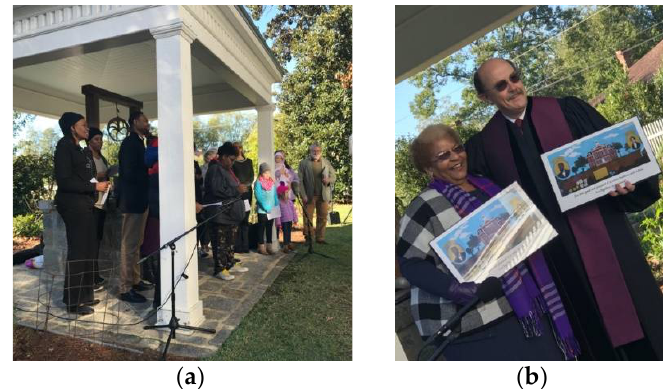
Figure 6. ( a ): Choir members of Holsey Memorial CME Church and Pierce Memorial United Meth- odist Church singing together at the Sunshine wedding re-enactment. ( b ): Reverend Gwendolyn Smith is pastor at Holsey Memorial CME Church in Sparta. Darrell McGinnis is pastor at Pierce Memorial United Methodist Church in Sparta. They are pictured together holding placards cele- brating the wedding re-enactment event. Photographs courtesy of Reverend Gwendolyn